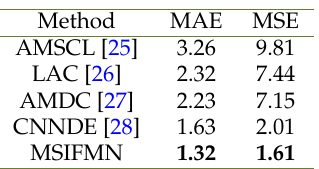
Table 2. Comparison with other state-of-the-art methods on Mall